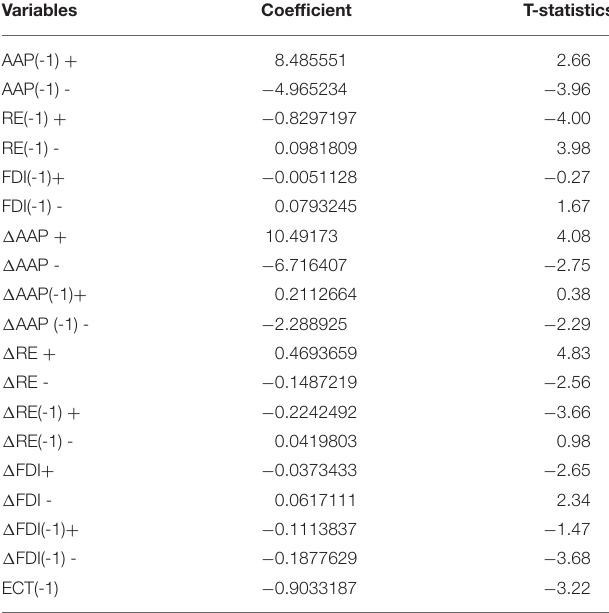
TABLE 2 | Short-run estimations.